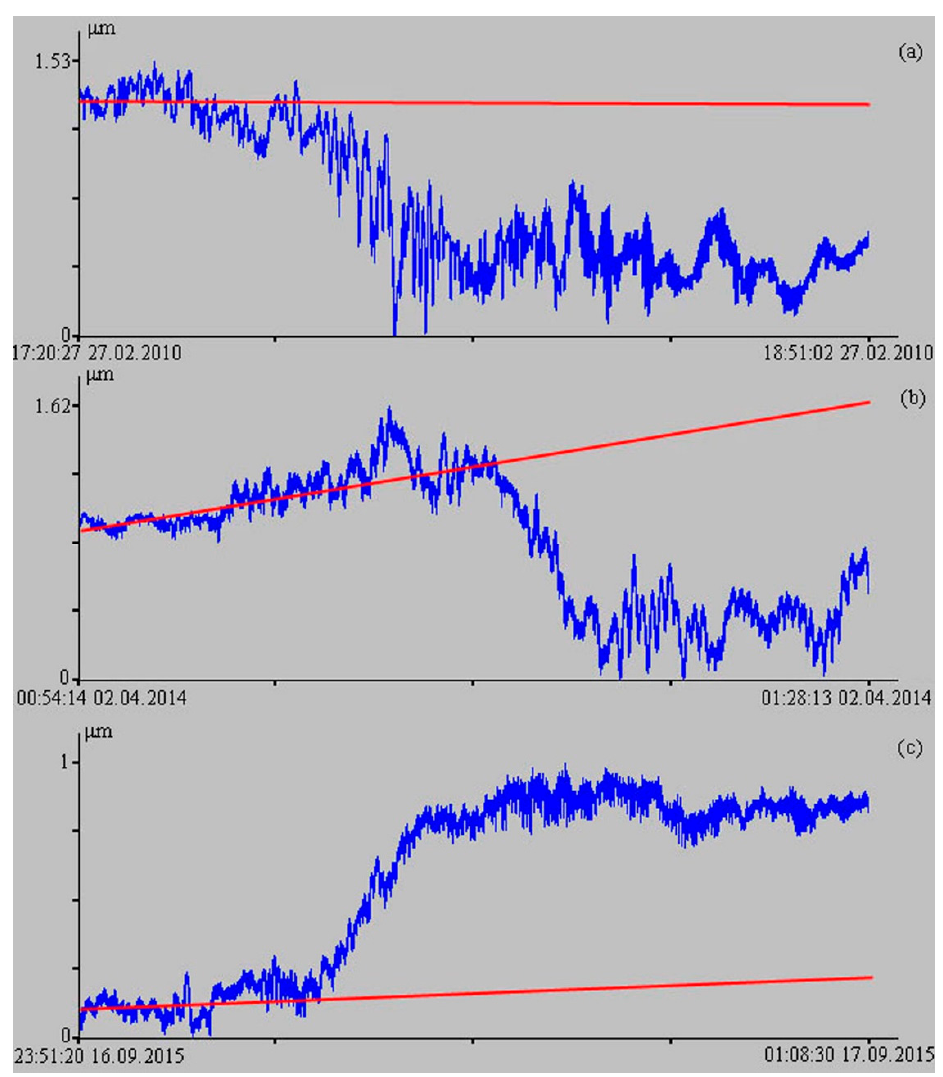
Figure 7. Fragments of 52.5 m laser strainmeter recordings from February 2010 ( a ), April 2014 ( b ), and September 2015 ( c ).